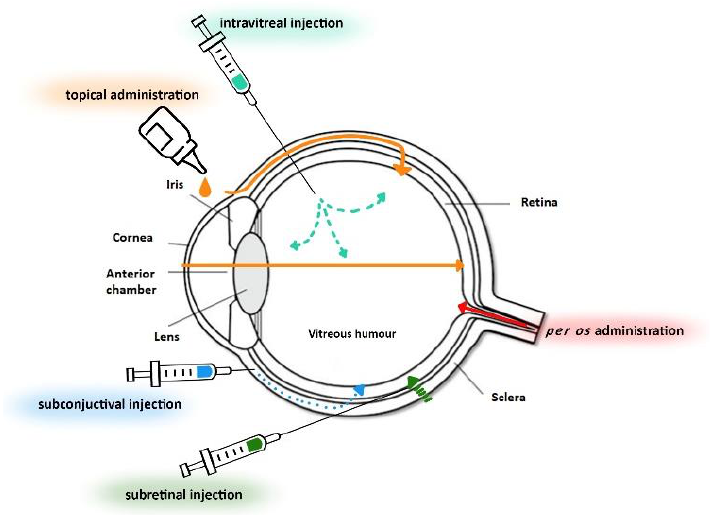
Figure 1. Basic anatomy of the eye and methods/routes of ocular drug administration: topical administration, subconjunctival injection, subretinal injection, intravitreal injection, and per os administration.